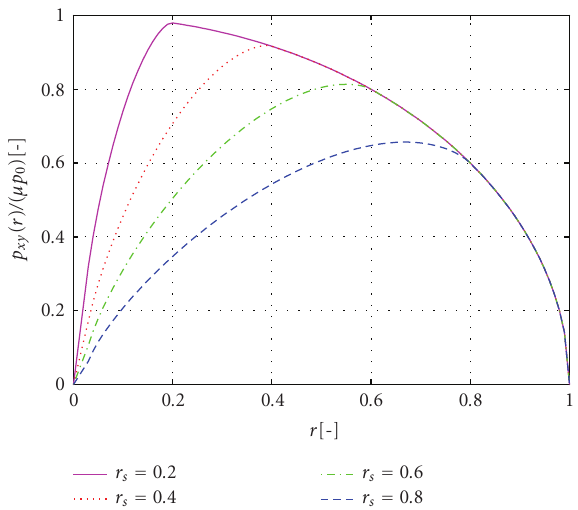
Figure 5: The radial shear traction distribution for di ff erent partial slip